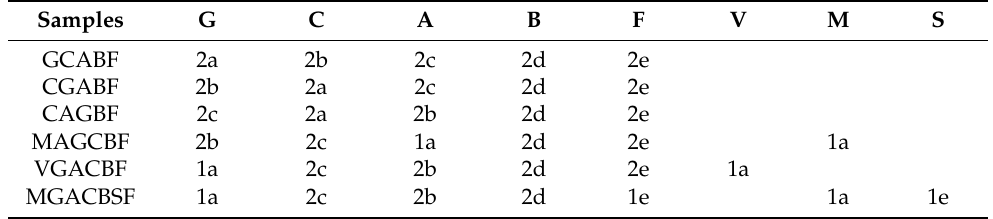
Table 1. Laminate stacking